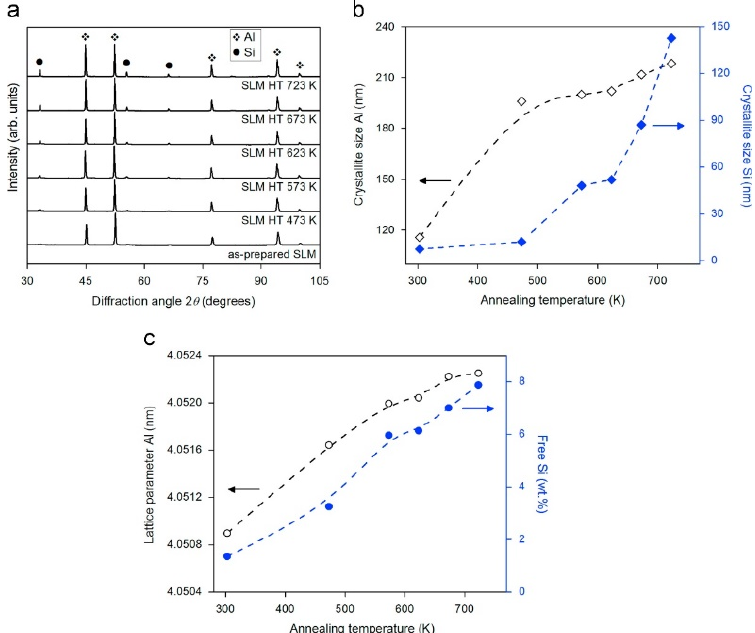
Figure 29. ( a ) XRD patterns (λ = 0.17889 nm) of the Al-12Si SLM specimens (γ = 90°) isothermally annealed for 6 h at temperatures between 473 and 723 K; ( b ) crystallite sizes of Al and Si, and ( c ) lattice parameters of Al and the amount of free Si versus the annealing temperature [67]. Copyright 2013. Adapted with permission from Elsevier Science Ltd. under the license number 4803720747532 (Figure